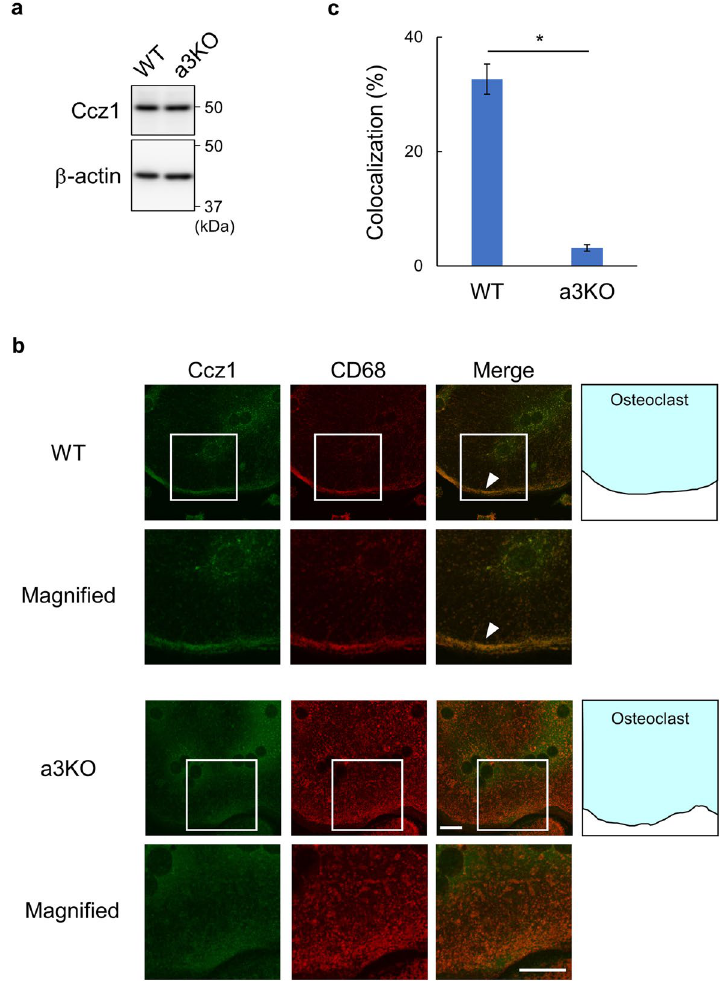
Figure 2. Localization of Ccz1 in WT and a3KO osteoclasts. ( a ) Ccz1 expression in WT and a3KO osteoclasts. Osteoclasts were differentiated from spleen macrophages derived from WT and a3KO mice, and the corresponding cell lysates were subjected to western blotting using anti-Ccz1 and anti-β-actin antibodies. Unprocessed scans of immunoblots are shown in Supplementary Fig. S4 online. ( b ) Localization of endogenous Ccz1 and lysosomes. WT and a3KO osteoclasts were obtained as in ( a ) and stained with anti-Ccz1 (green) and anti-CD68 (red) antibodies. Arrowheads indicate co-localization of Ccz1 and CD68 at the cell periphery. Schematic illustrations of osteoclasts and magnified images are also shown. The bars indicate 20 µm. ( c ) Lysosomal localization of Ccz1. Co-localization of Ccz1 and CD68 was observed, and the ratios of CD68- positive pixels that were also Ccz1-positive were calculated. Fifteen cells were randomly selected from three experiments using WT and a3KO cells. Means are shown with SEM. *P < 0.001 (unpaired two-tailed Student’s t